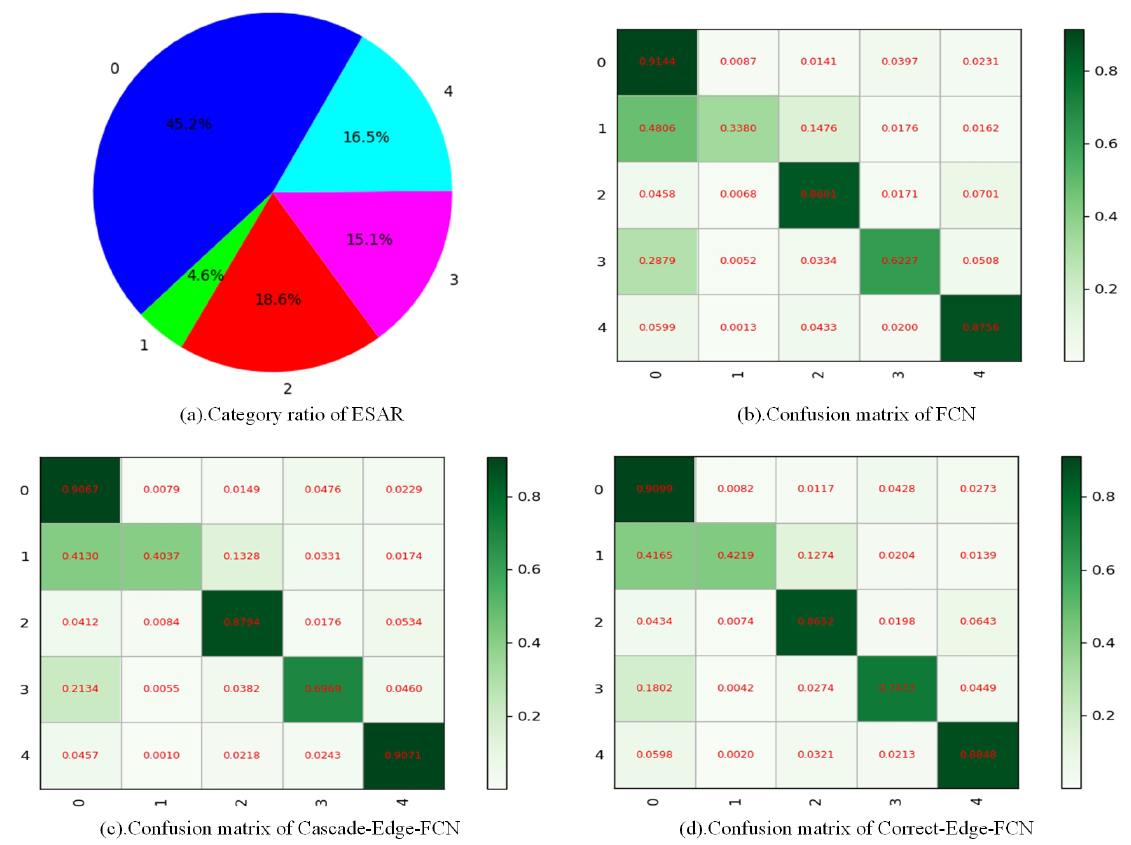
Figure 10. Category ratio of ESAR dataset and confusion matrices of three algorithms on ESAR Dataset. It reflects the probability of class i predicted to belong to class j